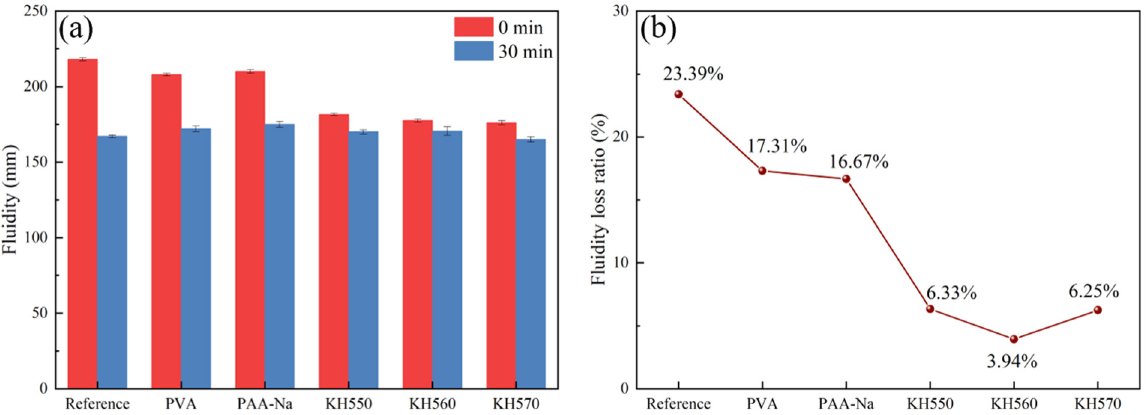
Figure 6. The fluidity ( a ) and fluidity loss ratio ( b ) of organic–inorganic composite geopolymer slurry.